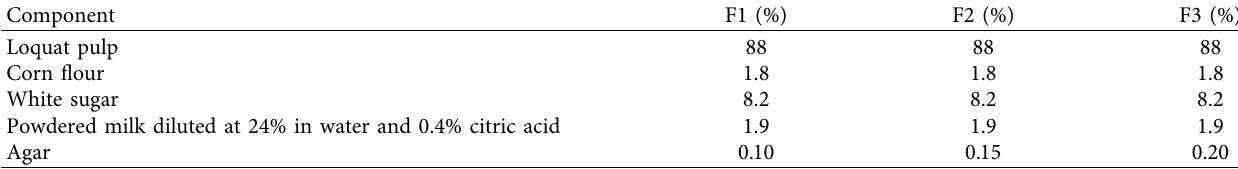
Table 1: Standard formulation of medlar compote ( Mespilus germ´anica